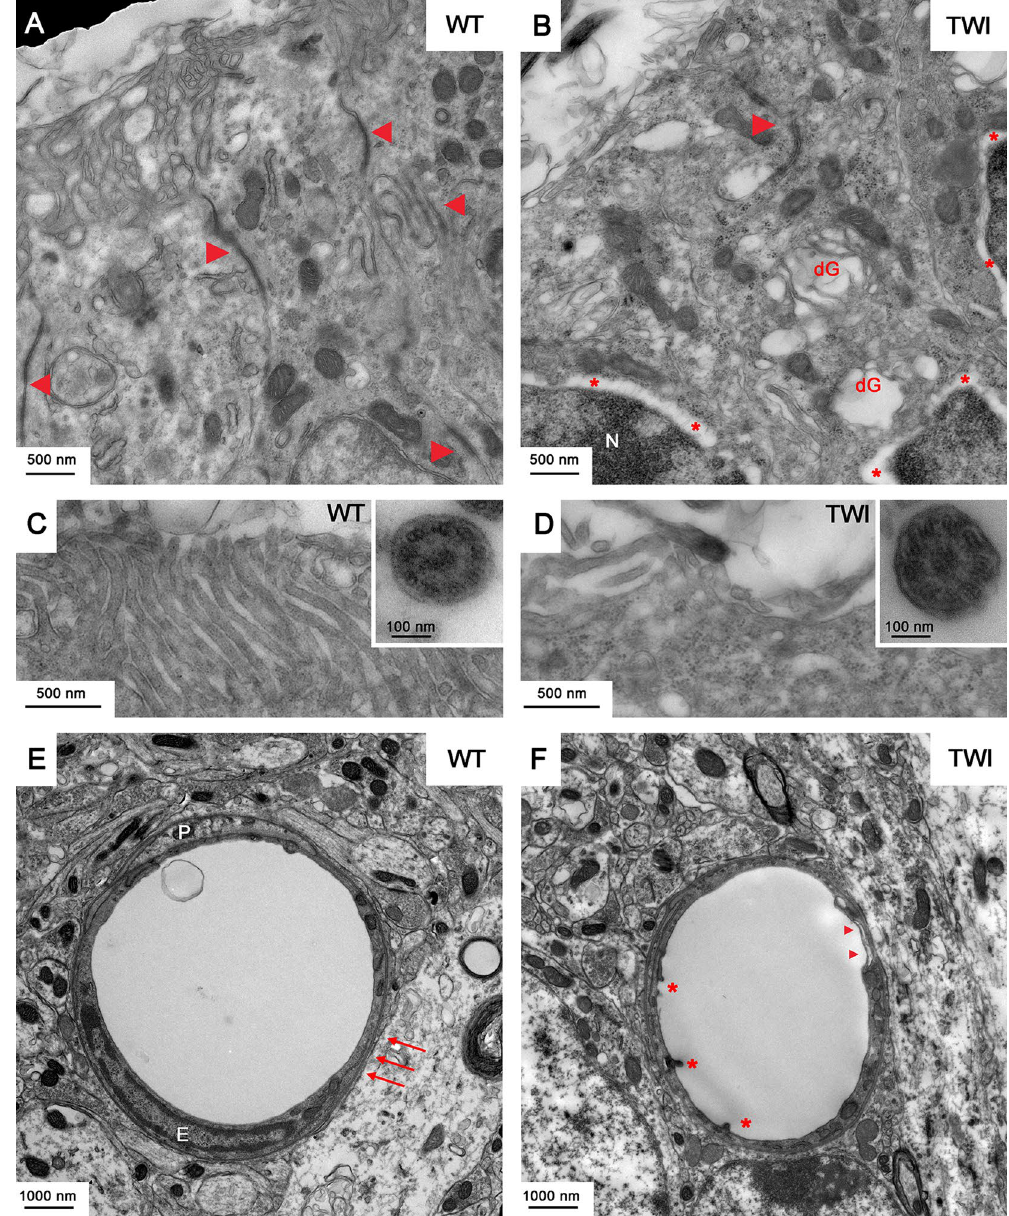
Figure 5. P30 ependymocytes and endothelial cells in spinal cord. ( A,B ) Representative TEM micrographs of the apical region of WT versus TWI ependymocytes. Arrowheads indicate cell to cell junctions; * indicate gaps separating the two lipid bilayers of the nuclear envelope; dG indicates degenerating Golgi’s cisternae. ( C,D ) Higher magnification images of microvilli and cilia (inset) in the apical region of ependymocytes of WT and TWI samples. ( E,F ) Architecture of WT versus TWI capillary; P: pericytes surrounding endothelial cells ( E ); arrows indicate evident basal membrane; * indicate intraluminal protrusions and arrowheads indicate thinner and discontinuous endothelial